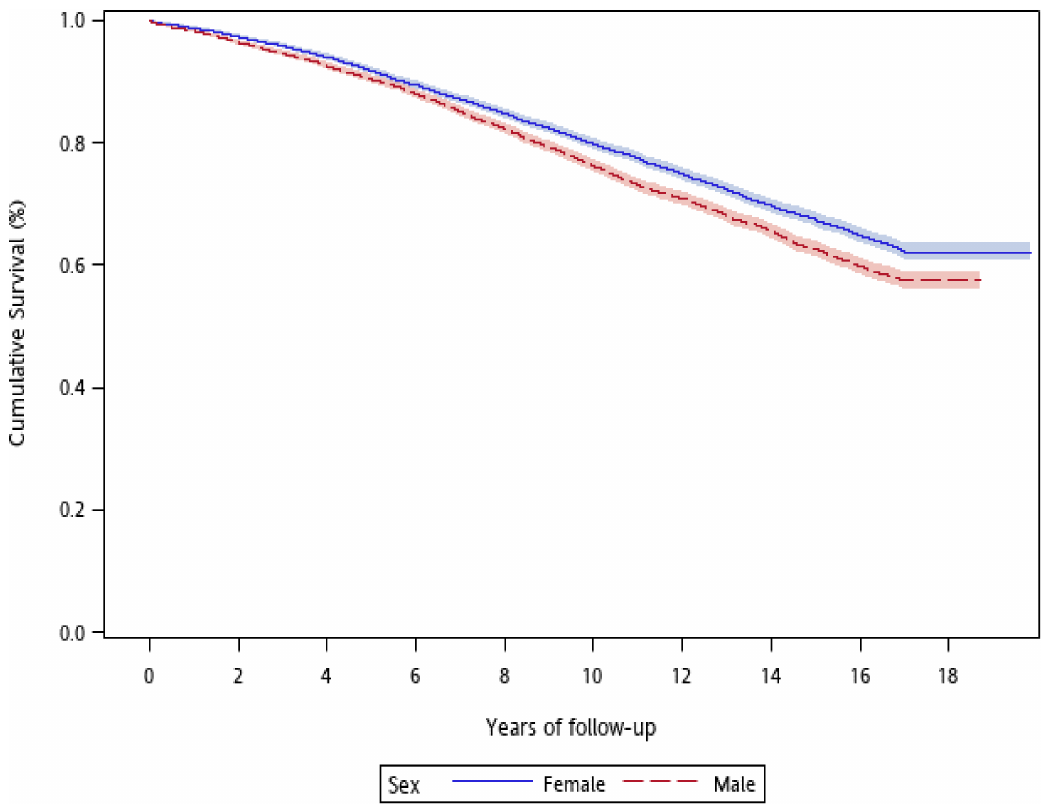
Figure 1. Sex-speci fi c survival curves in patients with type 1 diabetes